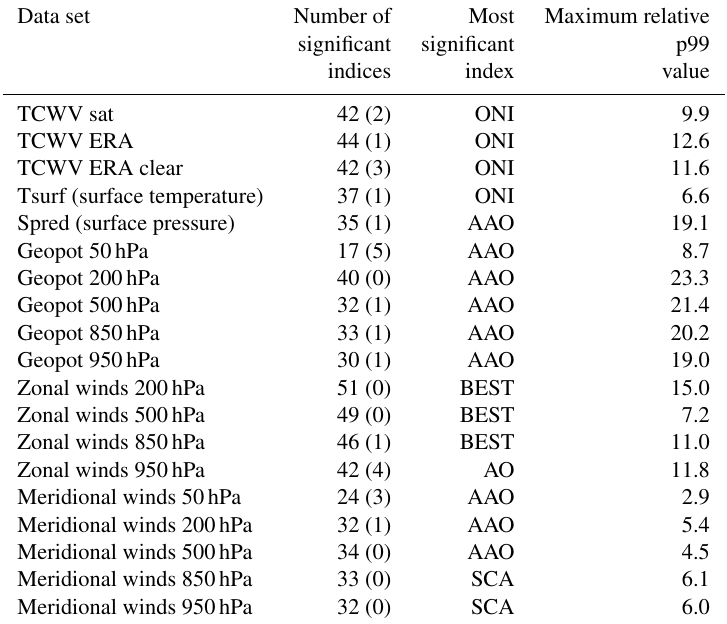
Table 3. Numbers of significant indices and most significant indices for all data sets (the number of indices with p99 values below the threshold but with shift ratios < 0.8 are indicated in brackets). The complete list of significant indices for the different data sets is provided in Table A1 in the